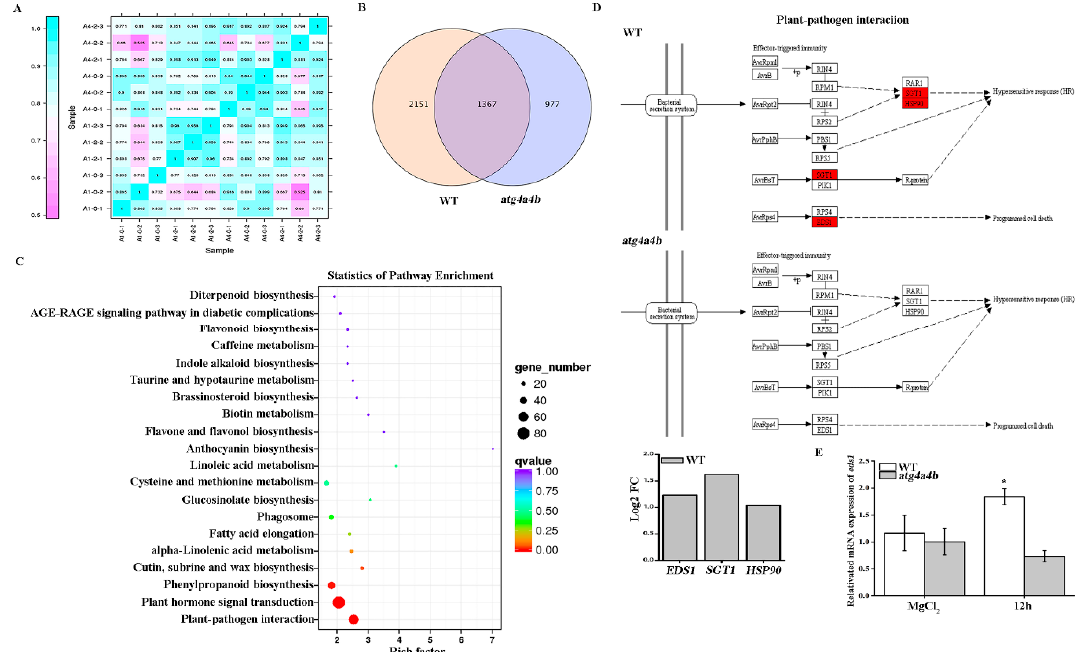
Figure 2. Enhanced disease susceptibility 1 (EDS1) was up-regulated under AvrRpt2 infection. ( A ) Correlation between RNA-Seq samples. A 1-0-1/2/3 represent three replicates of WT, A 1-2-1/2/3 represent three replicates of WT infected with AvrRpt2 , A 4-0-1/2/3 represent three replicates of atg4a4b and A 4-2-1/2/3 represent three replicates of atg4a4b infected with AvrRpt2 , heat maps of the correlation coe ffi cient between samples, the number represent R 2 that means the square of the Pearson coe ffi cient. ( B ) Venn diagram of expressed genes in WT and atg4a4b when infected with AvrRpt2 . FPKM > 1 is the expression threshold. ( C ) Transcriptome analysis of Kyoto Encyclopedia of Genes and Genomes (KEGG) enrichment in WT and atg4a4b when infected with AvrRpt2 for 12 h. ( D ) Transcriptome analysis of KEGG pathway of plants and pathogens interaction. The red color means that the expression was up-regulated. ( E ) The mRNA expression of EDS1 in WT and atg4a4b . Each data is three independent replicates. Each value is the mean ± SD of three replicates. Statistically significant di ff erences between treatments (* p <